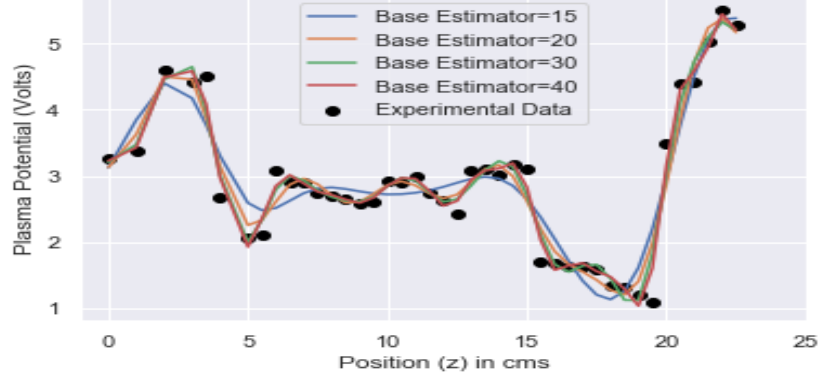
Figure 8. Prediction of axial plasma potential variation using regularised GBF regression